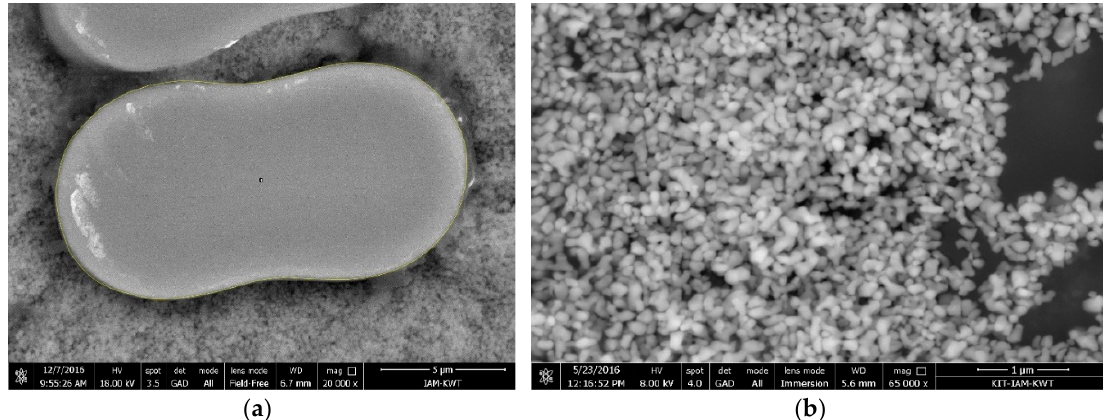
Figure 4. ( a ) Cross-sectional SEM image of a Nextel 610 ® aluminum oxide fiber, ( b ) SEM image of TM-DAR ® aluminum oxide powder.